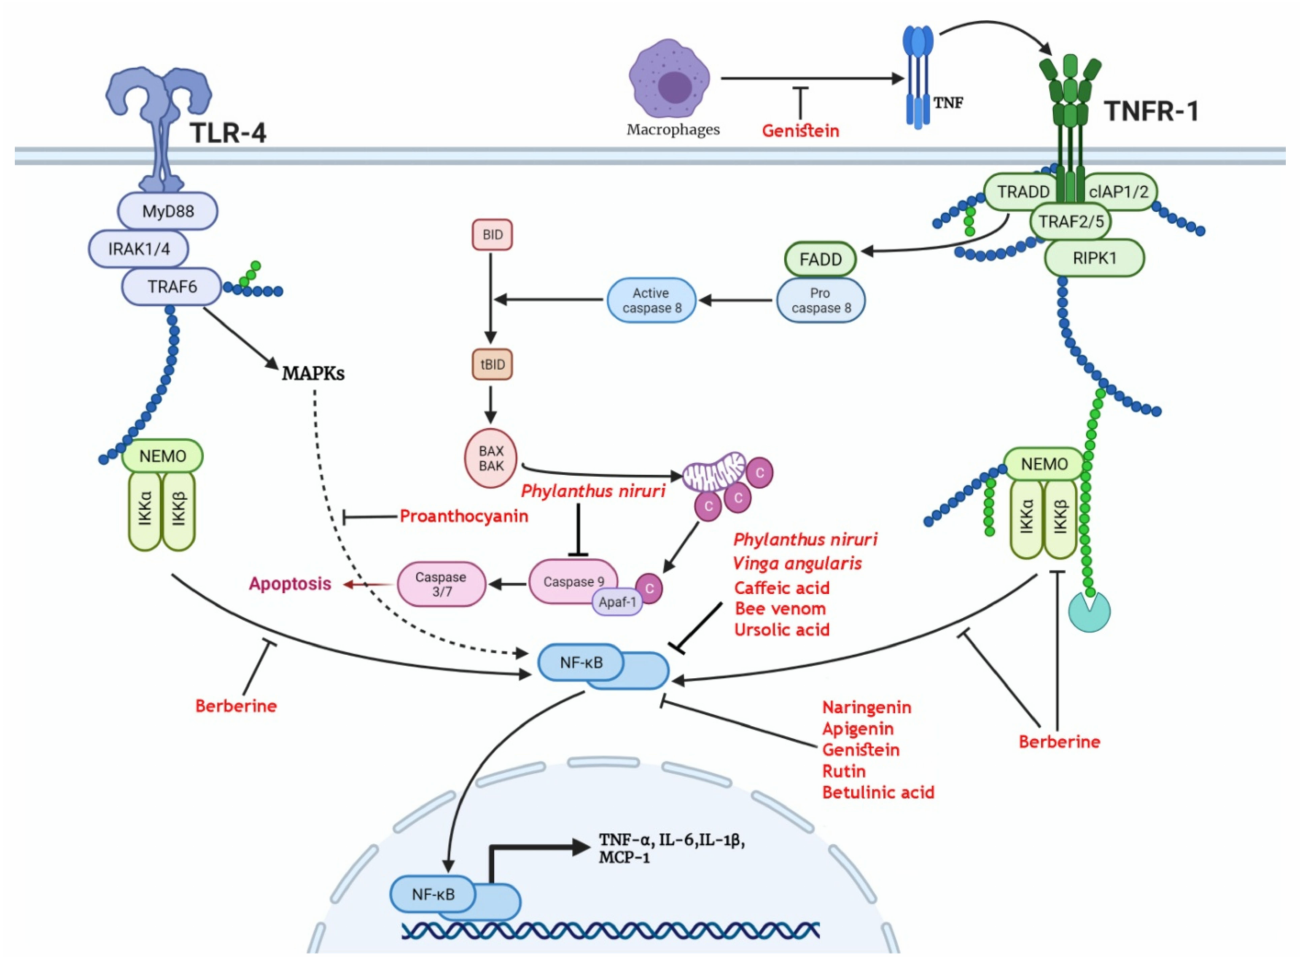
Figure 1. Medicinal plants and bioactive compounds that exert a protective effect through modulation of the nuclear factor kappa B(NF- κ B) pathway. Activation of either the tumor necrosis factor receptor 1 (TNFR-1) by tumor necrosis factor (TNF) or Toll-like receptor 4 (TLR-4) by pathogen-associated molecular patterns (PAMPS) leads to the recruitment of IkappaB kinase α (IKK α ) and IkappaB kinase β (IKK β ). These enzymes free NF- κ B from its sequestration in the cytosol. The tumor necrosis factor receptor type 1-associated death domain (TRADD) scaffold recruits Fas-associated death domain (FADD) that activates caspase 8, leading to the truncation of BH3-interacting domain (BID) to form tBID. Truncated BID (tBID) activates BCL2-associated X protein (BAX) and BCL2-antagonist/killer 1 (BAK) mitochondrial translocation and release of cytochrome c that activates effector caspases. Genistein exerts a protective effect through the inhibition of activation of TNFR-1. Berberine inhibits the recruitment of the NF- κ B essential modulator (NEMO) complex to TNFR-1 and reduces the activation of NF- κ B. Proanthocyanins inhibit mitogen-activated protein kinases (MAPKs)-mediated activation of NF- κ B. Phylanthus niruri , Vinga angularis , caffeic acid, bee venom, ursolic acid, naringenin, apigenin, genistein, rutin, and betulinic acid reduce the activation and nuclear translocation of